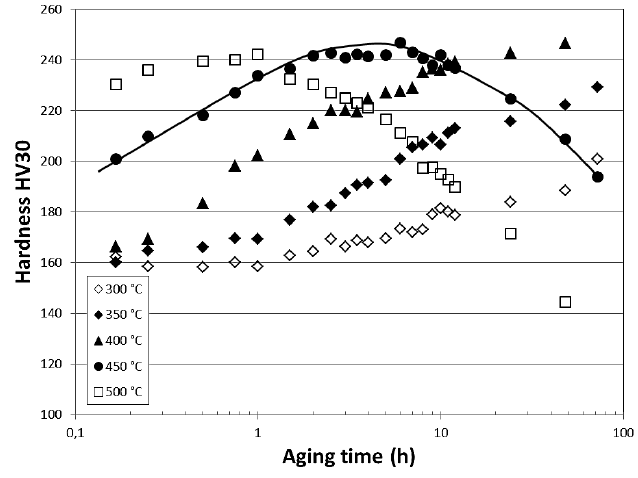
Figure 6. Aging curves of swaged CuNi3Si1Mg for different aging temperatures.